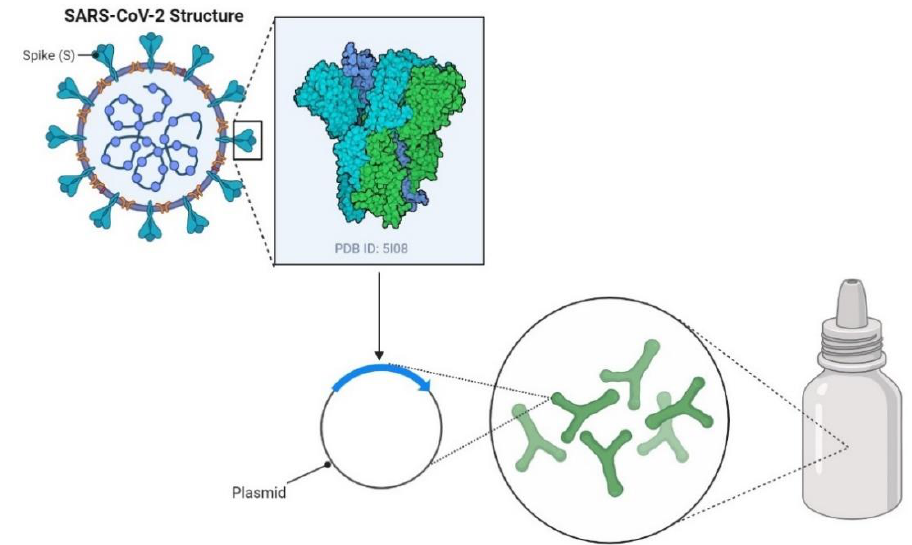
Figure 2. Diagram illustrating the development of the first oral COVID-19 vaccine candidate based on recombinant Bifidobacterium longum which has been engineered to deliver plasmids containing synthetic DNA encoding spike protein from SARS-CoV-2 (adapted from https://app.biorender.com/biorender-templates (access date: 06 March 2021)).